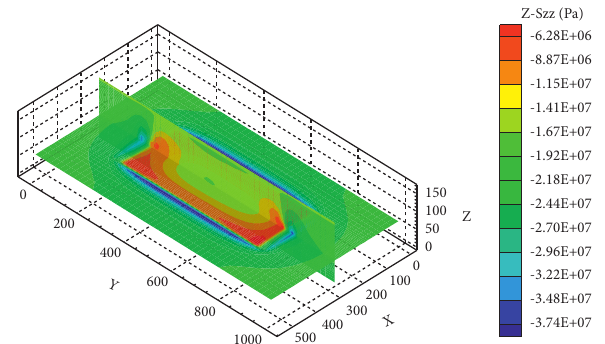
Figure 17: The stress change simulation diagram of the protected roof.